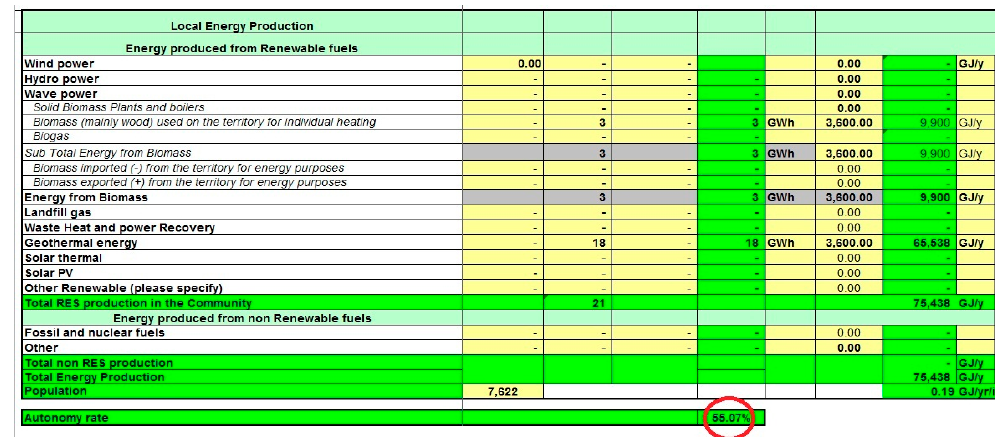
Figure 12. Energy consumption of Calim ă ne ș ti town.